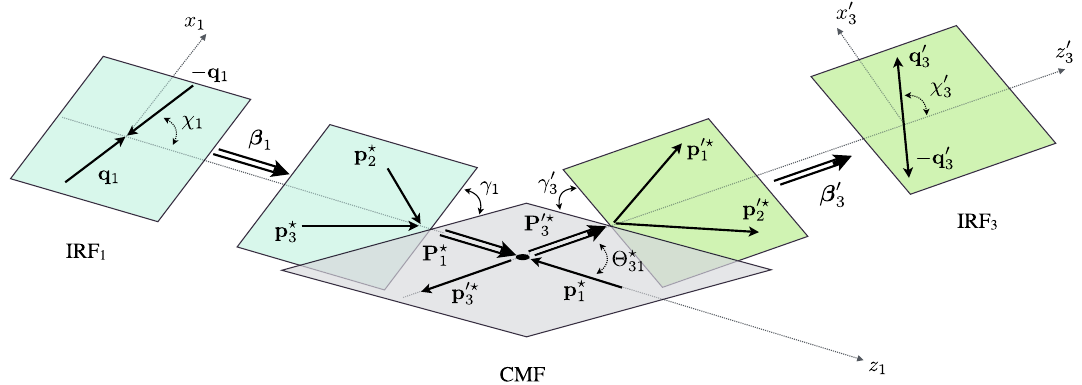
indicatethetransformationsbetweenthethree Lorentzboosts β 1 and β (cid:6) 3 frames